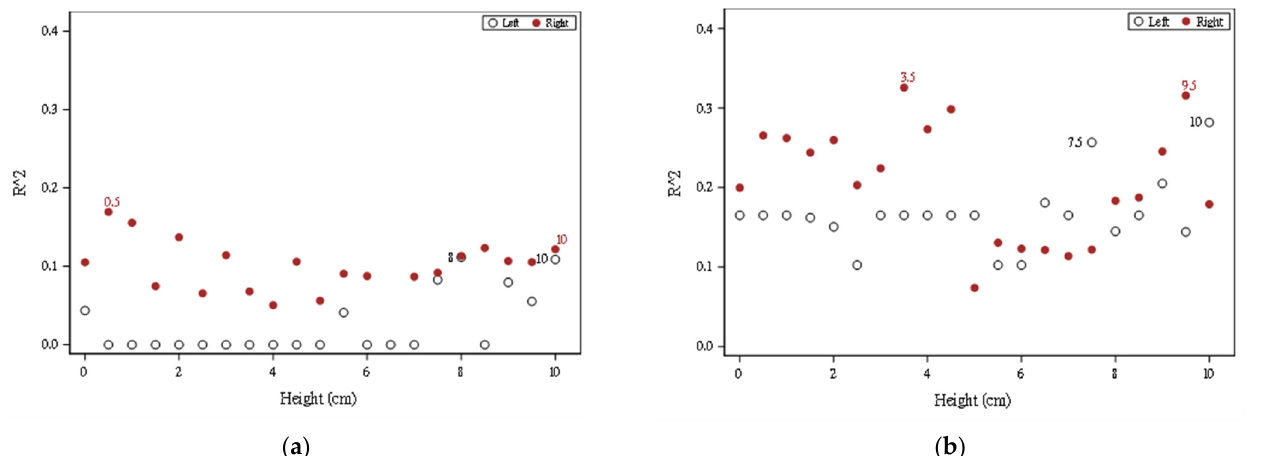
Figure 8. R 2 values for 21 models for Module II ( a ) using plantar pressures; ( b ) using plantar pressures and personal features.